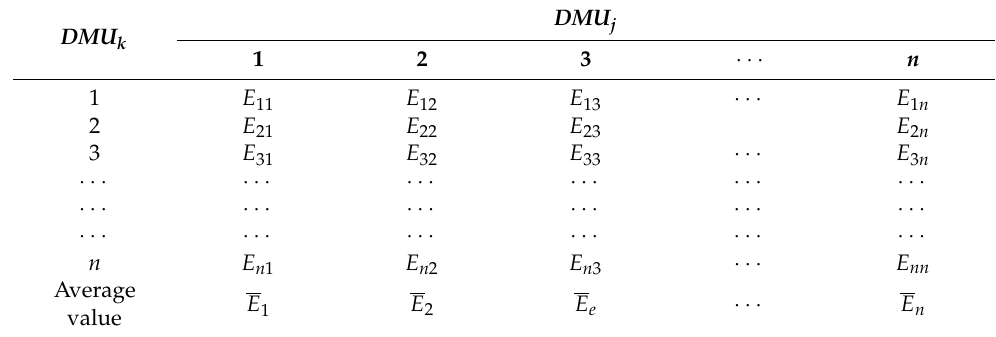
Table 3. Cross efficiency matrix